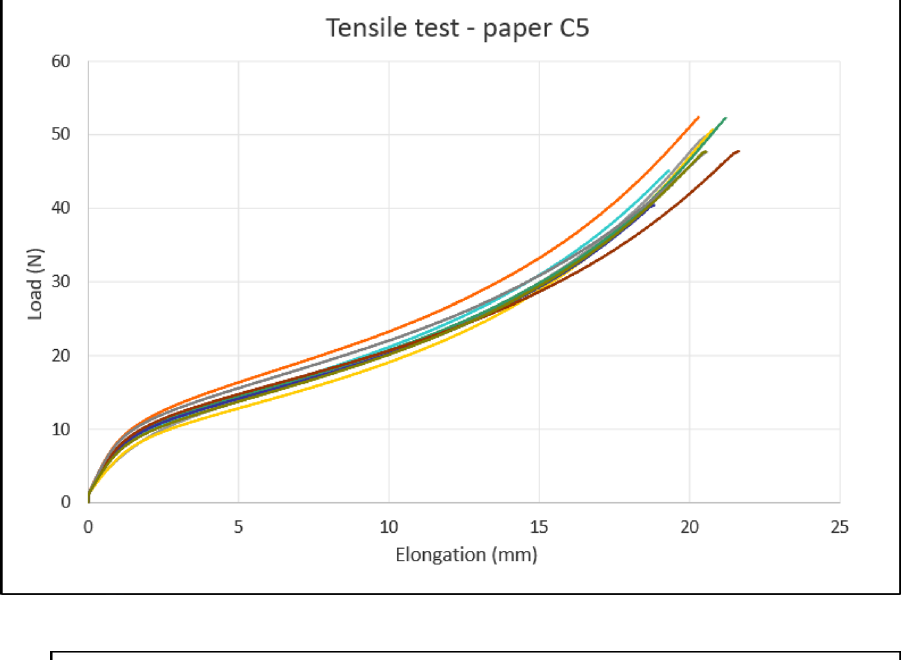
Fig. 31 Force elongation curves of individual specimen of paper